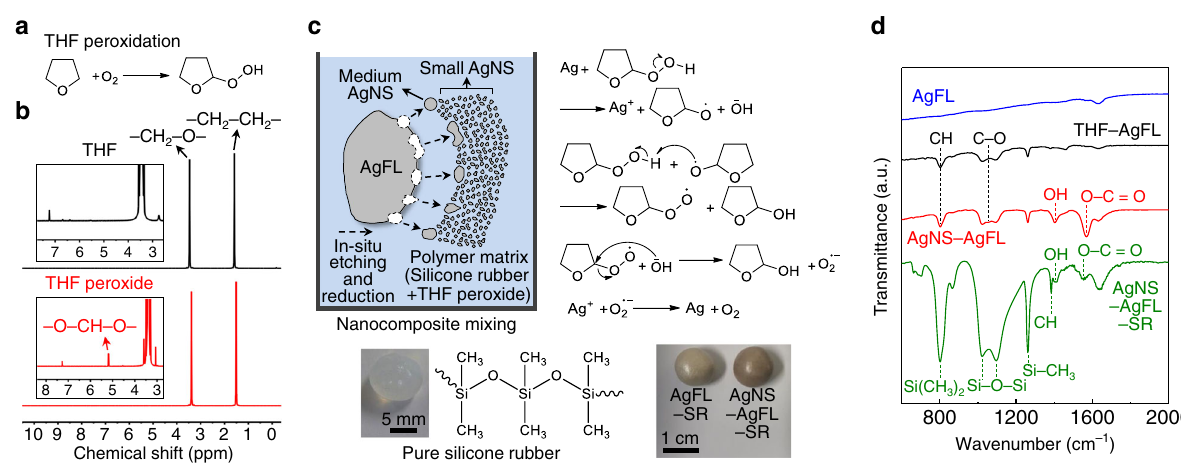
Fig. 1 Synthesis of hierarchically structured AgNS particles. a Oxygen peroxidizes THF into THF peroxide. b 1 H NMR spectra of THF and THF peroxide. c Schematic and chemical mechanism of the radical and reactive oxygen species-mediated vigorous etching and reduction reaction of AgFLs into AgNS particles in a SR matrix. Optical images of the pure SR, AgFL-SR (Ag = 44 vol%), and AgNS-AgFL-SR (Ag = 44 vol%, THF peroxide = 15 mL) nanocomposites are also shown. d FTIR spectra of the pure AgFLs, THF-AgFLs, AgNS-AgFLs, and AgNS-AgFL-SR (Ag = 44 vol%, THF peroxide = 15 mL)